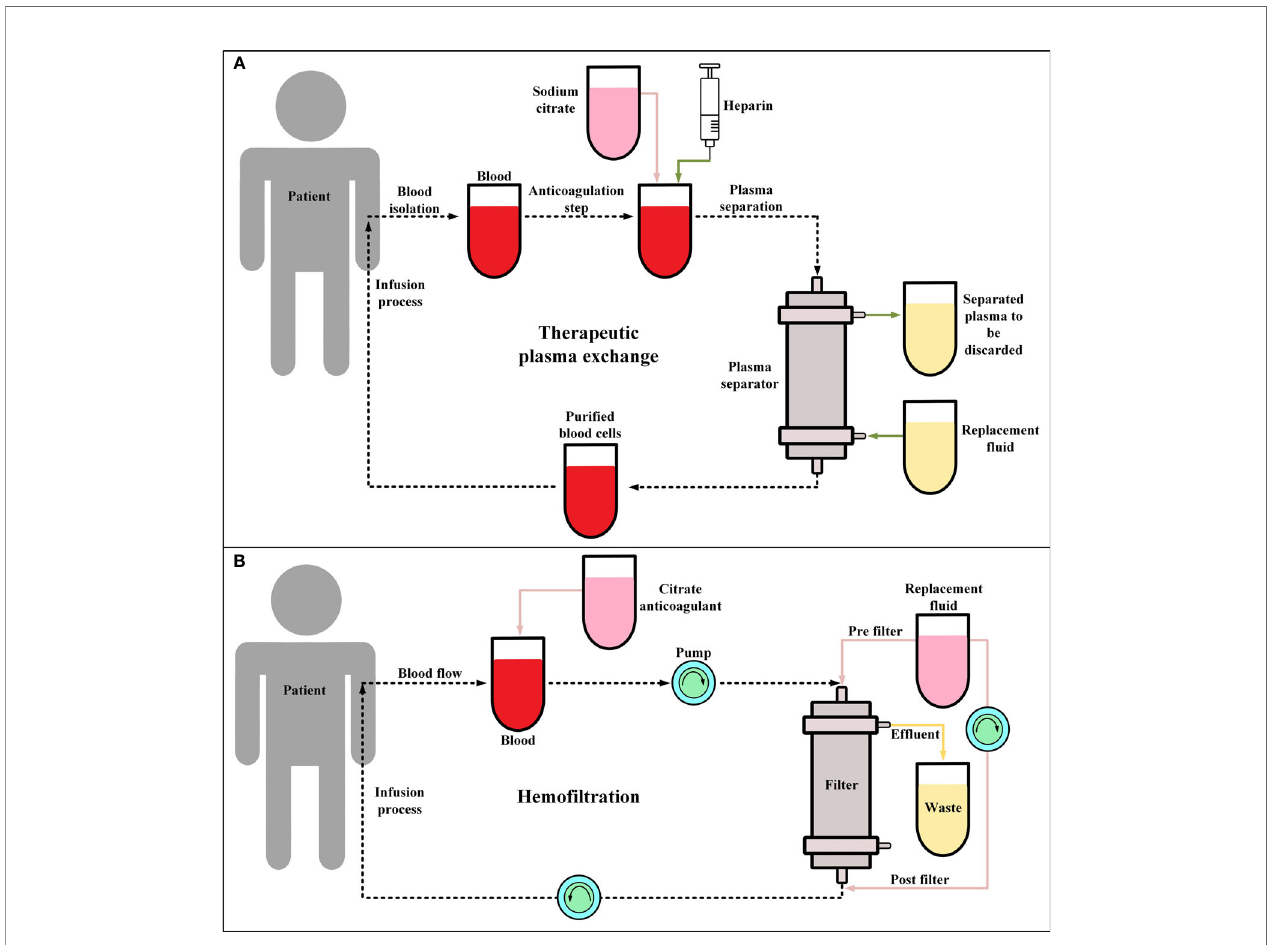
FIGURE 2 | Therapeutic plasma exchange (TPE) and hemo fi ltration . (A) The general procedure of TPE. Conventionally, in the anticoagulation step, sodium citrate or heparin are utilized. Moreover, the replacement fl uid consists of albumin or fresh frozen plasma. (B) The procedure of continuous veno-venous hemo fi ltration (CVVH) for hemo fi ltration. During CVVH, a patient ’ s blood is fi ltered by the means of highly semipermeable membranes (known as fi lter) and the ultra fi ltrate (wastes) is separated by a process known as convection. Of note, the replacement fl uid is added prior to or after hemo fi